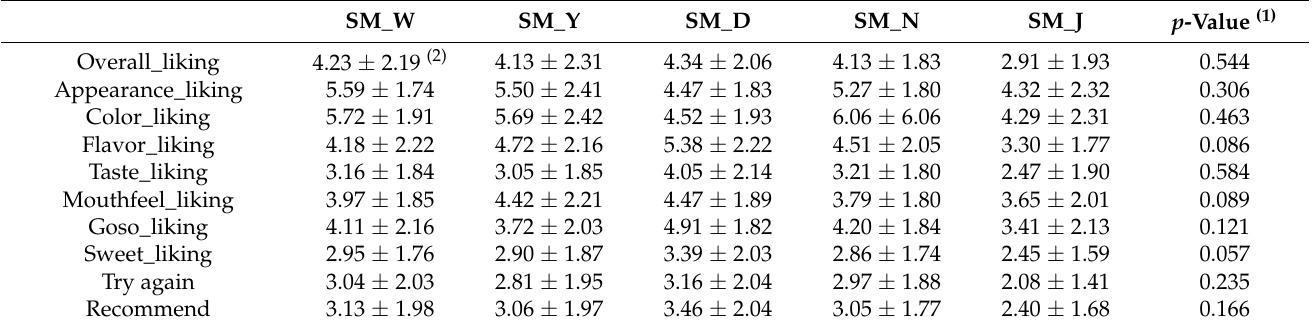
Table 4. Consumer acceptability of five